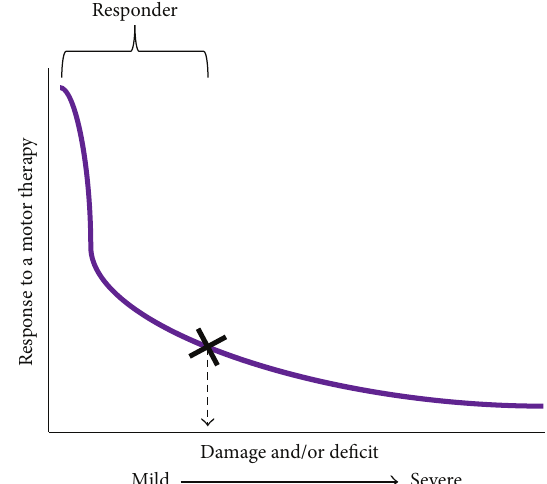
Figure 3: Presenting a schematic of unimodal models of recovery. Typically, unimodal models show how recovery following a motor therapy varies as a function of patient’s individual characteristics, like damage to ipsilesional pathways, or impairment of the paretic limb. When characteristics are plotted against patient’s response to motor therapy, one can understand who achieves criterion level of recovery (marked by X). Patients who achieve at least the criterion level or greater recovery are known as “responders.” Others are consideredtohavehitthe“pointofnoreturn”(seeStinearetal.[81]). Degree of damage or deficit (or any other patient characteristic) that separates responders from nonresponders is deemed as cut-off to stratify patients for said therapy. It is important to note that criterion level of recovery, hence the cut-off, can vary from one therapy to another therapy and from study of one characteristic to another. If extrapolated, such recovery models can be effective at predicting who would respond to stimulation of ipsilesional